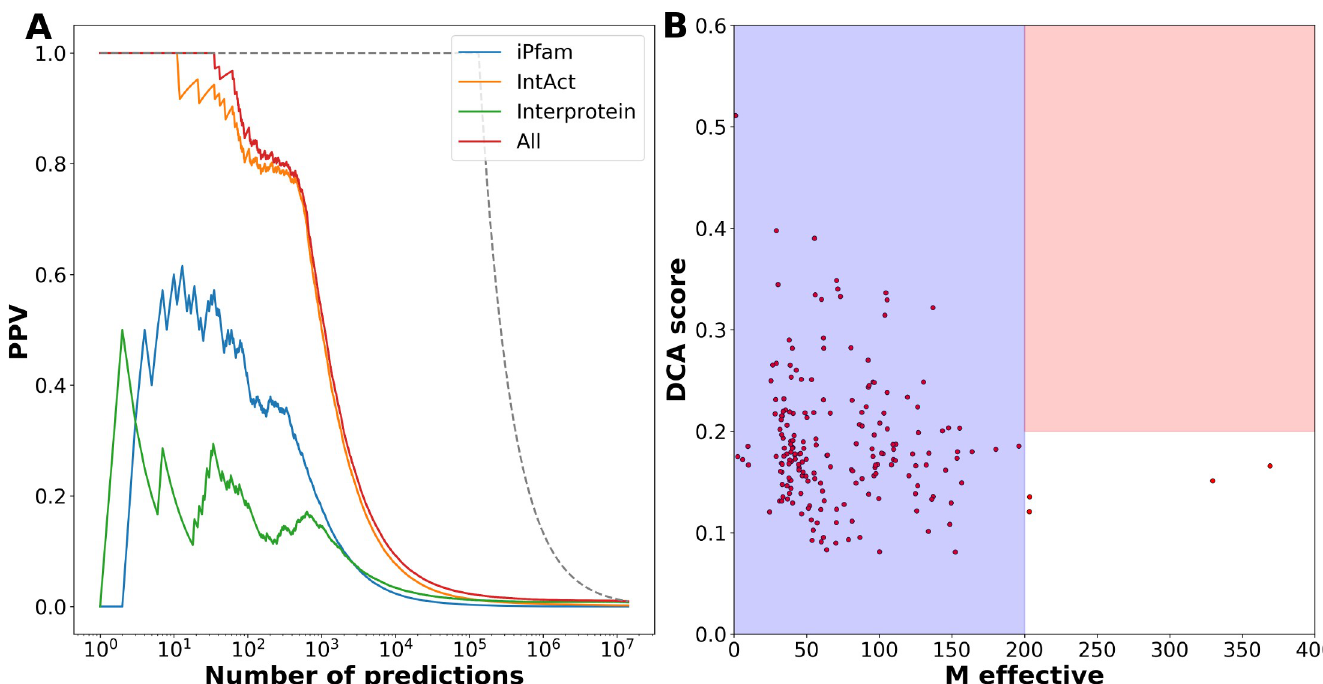
Fig 5. Performance of our multi-scale coevolutionary analysis for human protein domains. – Panel A shows the positive predictive value of the phyletic couplings for predicting positive domain-domain relationships (including protein architecture, iPfam and human IntAct entries). While there is a clear overrepresentation of intra-protein localization in between the highest-scoring domain pairs, also physical interactions as captured by iPfam and IntAct are enriched in particular in the first ca. 10 3 phyletic couplings. The overall performance is coherent with the one found in the bacteria. Panel B shows the paralog-matching and DCA results for the 200 most coupled domain pairs, which are not in the positive-relation dataset. We observe that currently the joint MSA are too small (Meff < 200) to allow for a reliable application of DCA to detect inter-protein residue-scale coevolution.